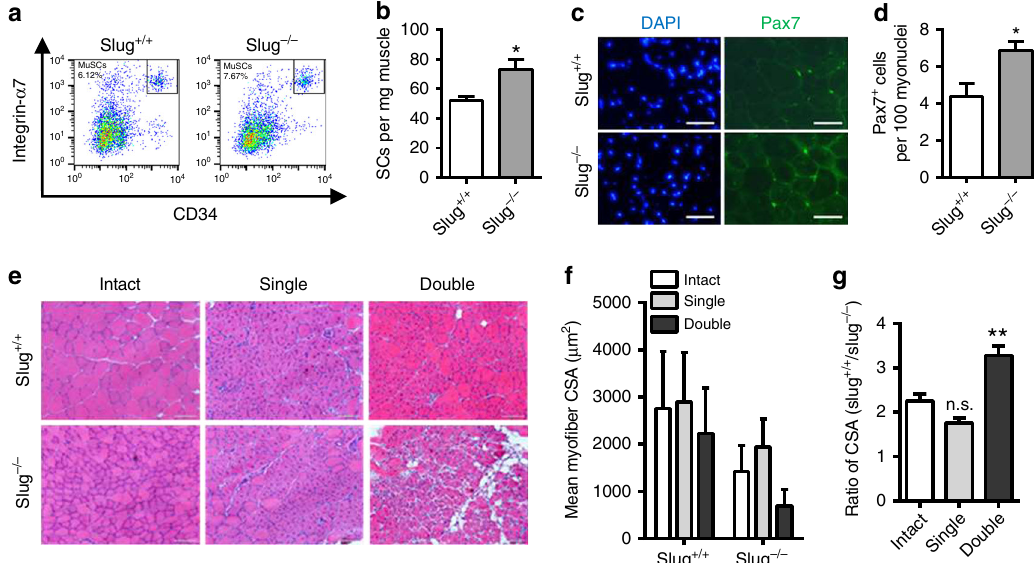
Fig. 1 Slug de fi ciency repairs regenerative capacity of SCs during serial muscle damage. a Representative fl ow cytometric analysis of the frequency of SCs (CD45 − /CD11b − /CD31 − /Sca1 − /Integrin- α 7 + /CD34 + ) subpopulation in Slug + / + and Slug − / − mice. b Yield of SCs per milligram (mg) of muscle from Slug + / + and Slug − / − mice ( n = 6 mice per group). * p < 0.05 by student ’ s t -test. c Representative IHC images of Pax7 + SCs within the intact tibialis anterior (TA) muscles of Slug + / + and Slug − / − mice. DAPI was used as nuclear counterstaining. Scale bar, 100 μ m. d Quanti fi cation of Pax7 + SC numbers in c . * p < 0.05 by student ’ s t -test. e H&E staining of the intact and injured TA muscles in Slug + / + and Slug − / − mice ( n = 5 mice per group). For